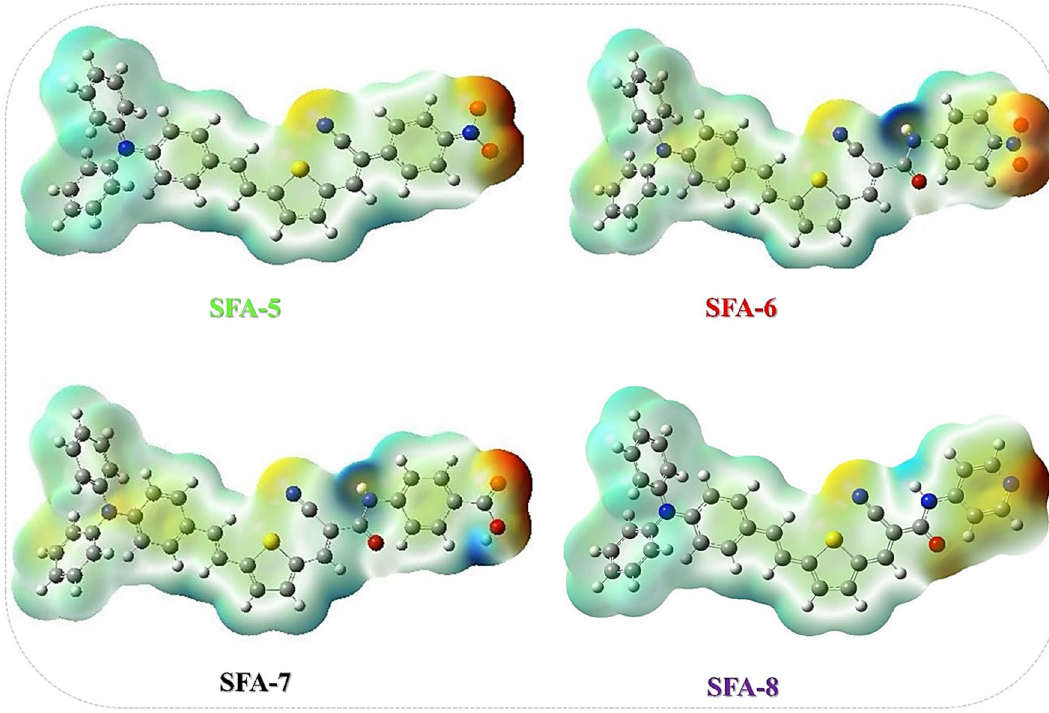
Figure 9. Molecular electronic potential diagram (MEP) of SFA-5–8